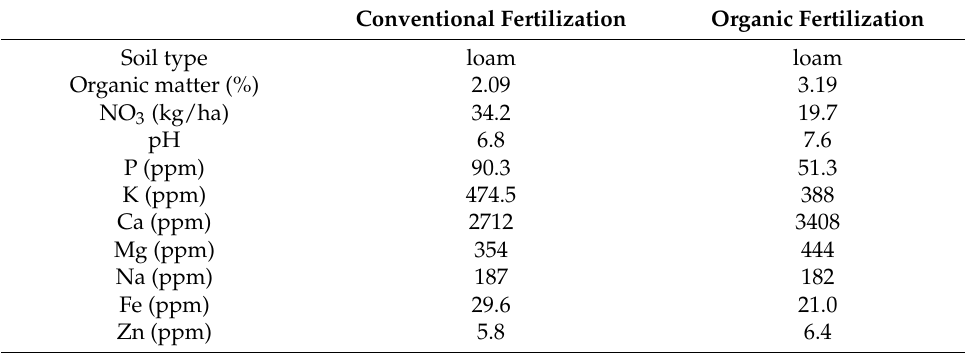
Table 3. Soil composition after fertilization